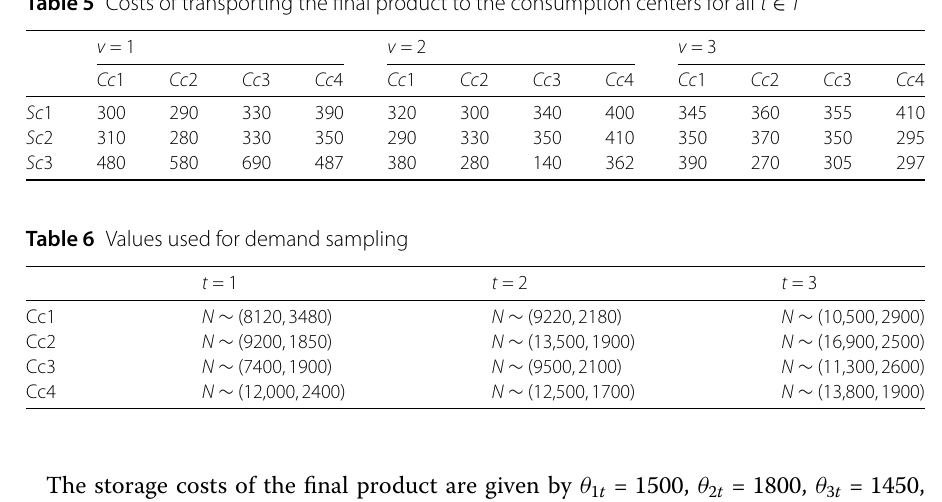
Table 5 Costs of transporting the final product to the consumption centers for all t ∈ T v = 1